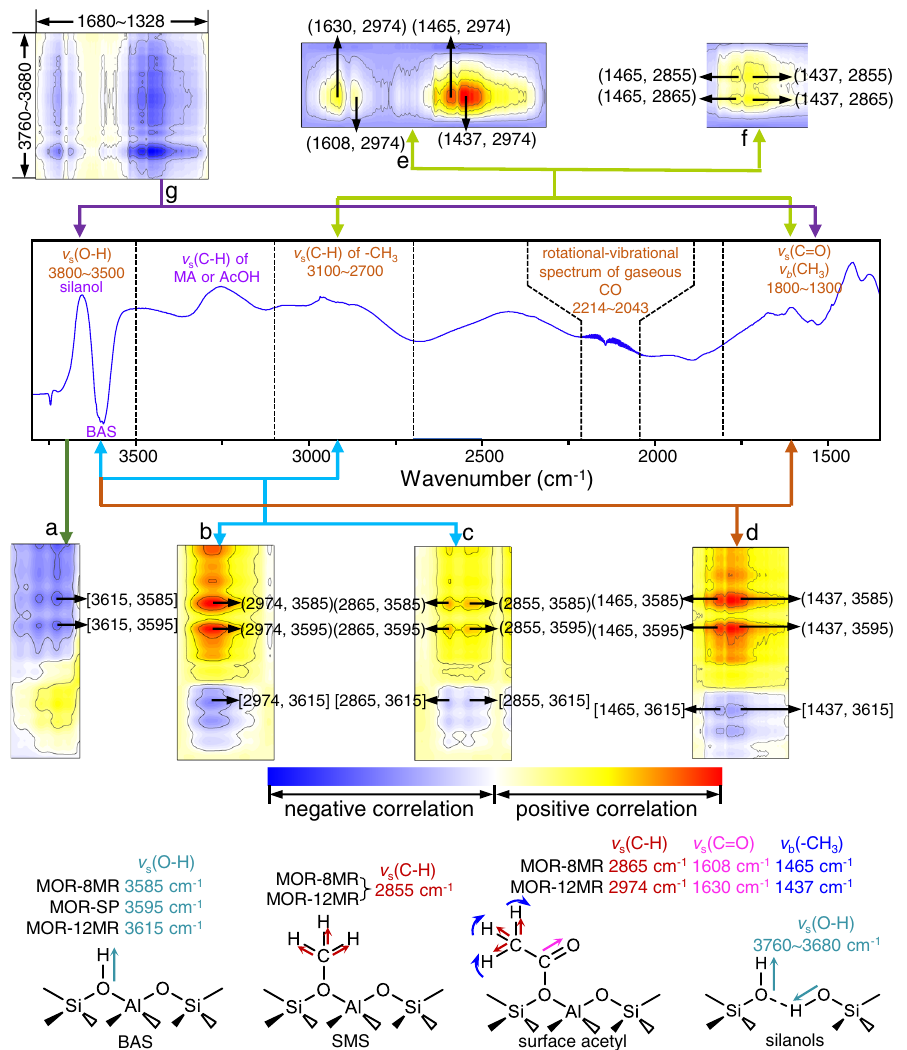
Fig. 8 | 2D COS maps of the rapid scan FT-IR spectra. Positive and negative correlationsbetween v 1 and v 2 : a v s (O – H)ofBASsinMOR-12MRand v s (O – H)ofBAS inMOR-8MRandMOR-SP, b